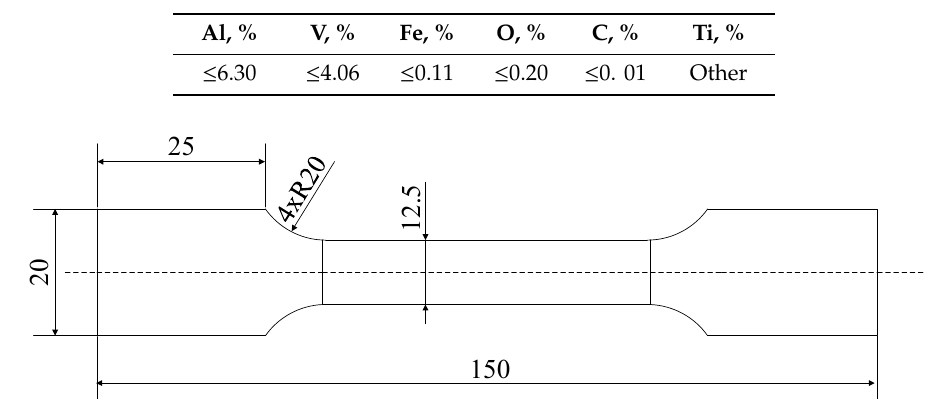
Figure 1. The geometry of the specimen used for the uniaxial tensile tests (unit: mm).